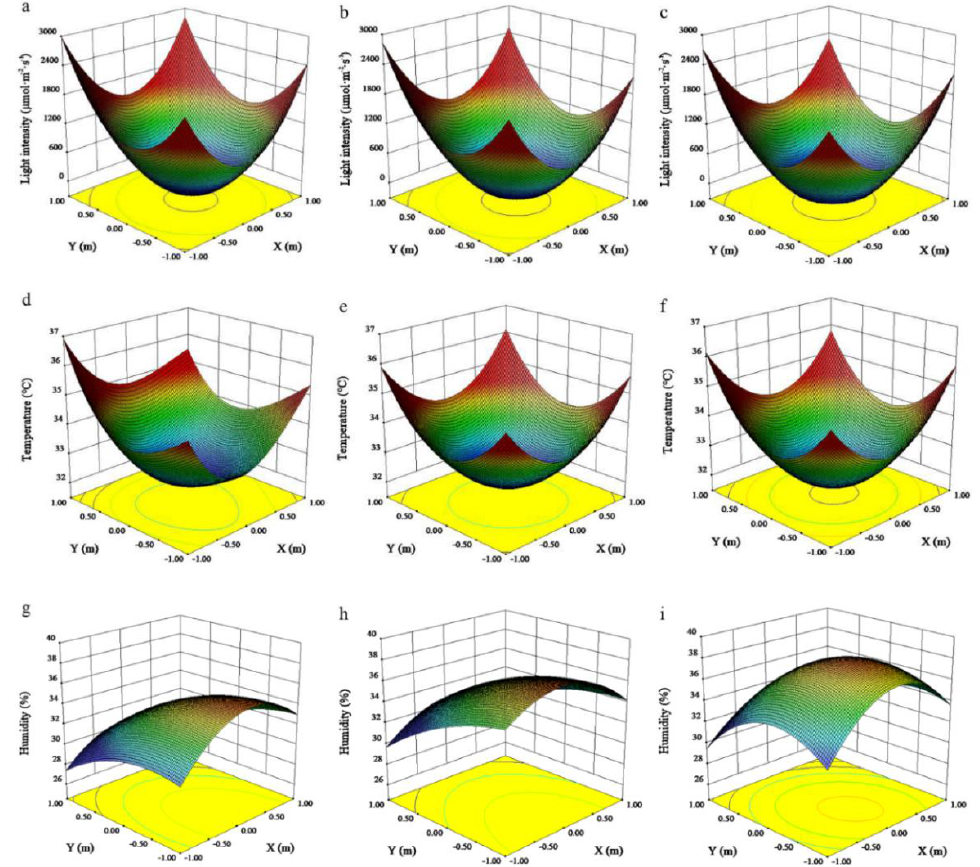
Figure 4. Distributions of canopy microclimates in the di ff erent layers over the whole fruit development period. The x -axis shows the distance in the east ( + ) and west ( − ) directions from the trunk. The y -axis shows the distance in the south ( + ) and north ( − ) directions from the trunk. The z -axis represents each microclimate factor. ( a ) Light intensity in the top layer; ( b ) light intensity in the middle layer; ( c ) light intensity in the lower layer; ( d ) temperature in the top layer; ( e ) temperature in the middle layer; ( f ) temperature in the lower layer; ( g ) humidity in the top layer; ( h ) humidity in the middle layer.; ( i ) humidity in the lower layer.